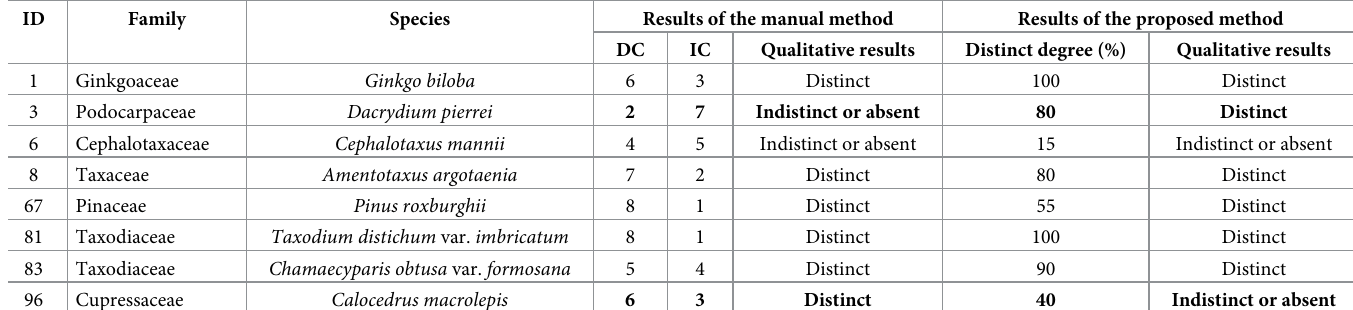
Table 2. Different judgments on 8 cross-sections.